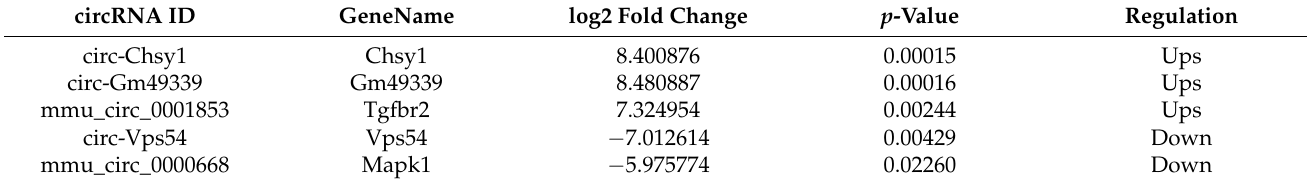
Table 2. The sequencing results of differential circular RNAs.